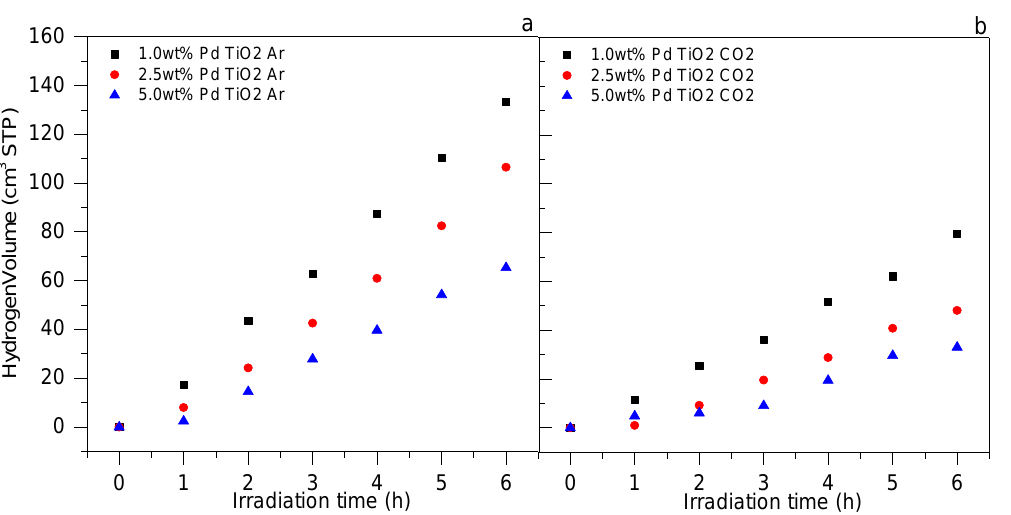
Figure 8. Cumulative hydrogen production using xPd–TiO 2 (x = 1.00, 2.50 and 5.00 wt%) and under two atmospheres: ( a ) argon and ( b ) CO 2 . Conditions: photocatalyst concentration 0.15 g/L, 2.0 v/v% ethanol, pH = 4 ± 0.05 and near-UV light. Standard deviation: ( a ) ±3.0%, ( b ) ±3.4%.